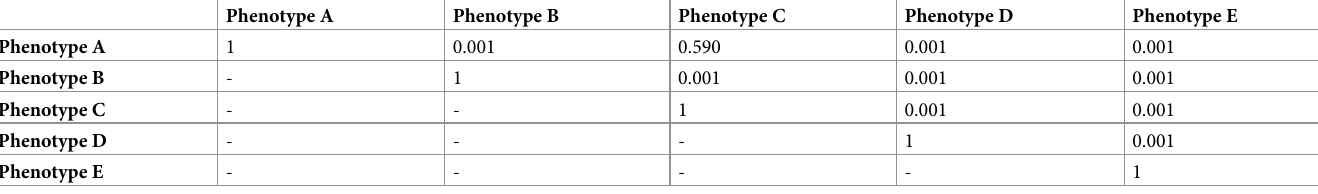
Table 3. Statistical separation of UMAP clusters between GAN generated datasets.